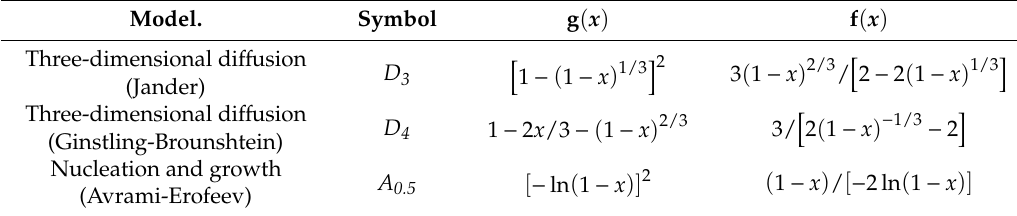
Table 7. Typical kinetic model functions expressions of g(x) and f(x) for solid-state reactions [40]. Model. Symbol g ( x ) f ( x ) Three-dimensional di ff